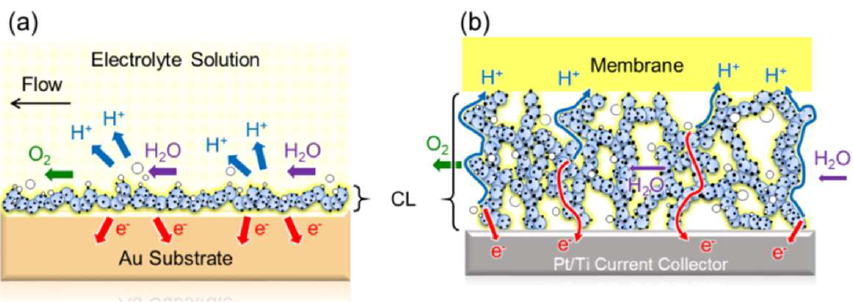
Figure 4. Schematic images of the IrO x /M-SnO 2 anode catalyst layer (CL) during the OER in ( a ) electrolyte solution (half cell) and ( b ) a single cell.